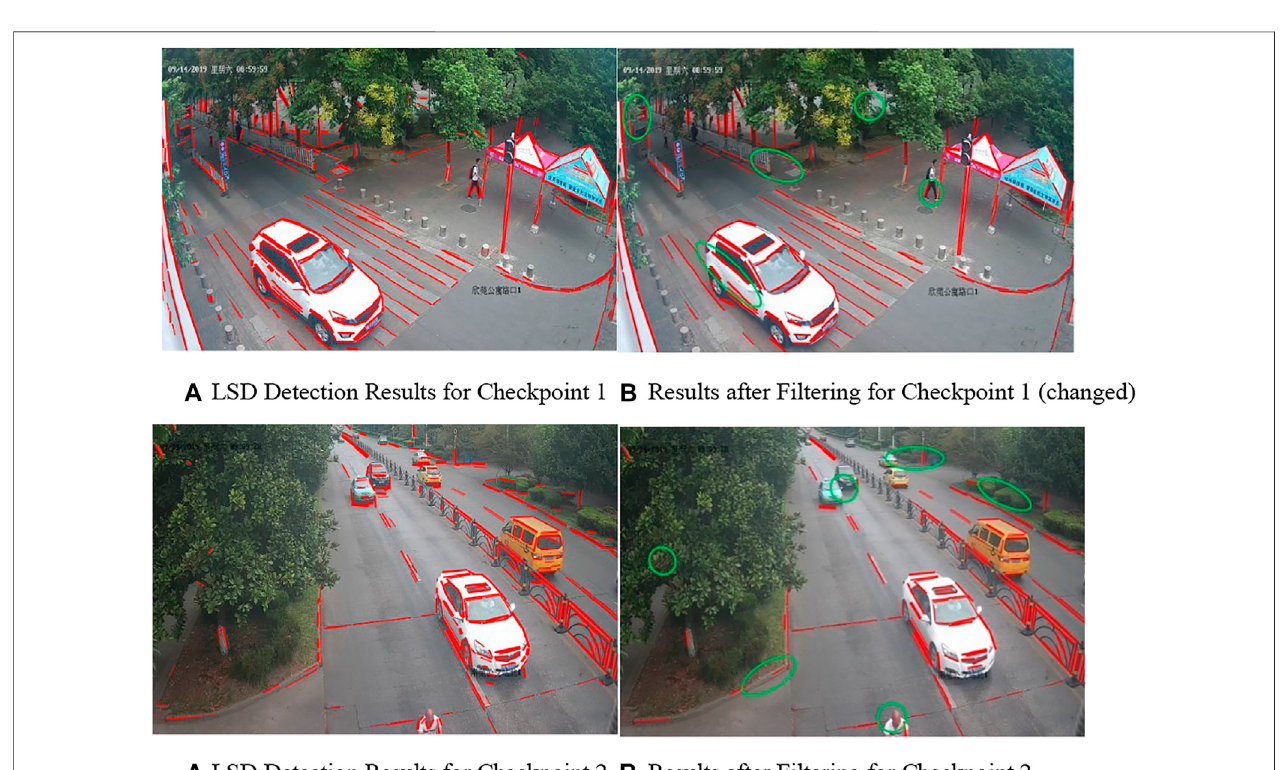
FIGURE 4 | Results of line detection and fi ltering. (A) LSD detection results for checkpoint 1 (B) results after fi ltering for checkpoint 1 (changed). (A) LSD detection results for checkpoint 2 (B) results after fi ltering for checkpoint 2.